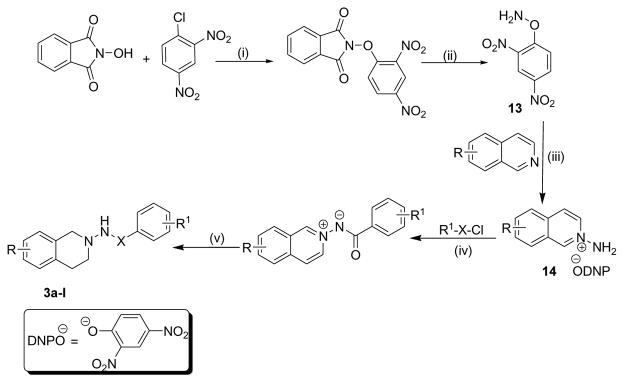
Reaction Conditions: (i) Et3N, RT, 2 hours, (ii) NH2.NH2. H2O, CH2Cl2, MeOH,0 °C, (iii) CH3CN, 50 °C,(iv) Et3N, THF, 25 °C, (v) NaBH4, EtOH, RT; X = CO, SO2 R= 5-OCH3, 5-OH, 5-NHCOCH3, 5-NH-CO-C6H4-C2H5, 5-OCH2-C6H5, 7-OCH3, 7-COOCH3, 5,8-di-Br, 6-COOH, 5-OSO2-C6H4-OCH3; R1 =4-C(CH3)3-C6H4, 4-C2H5-C6H4, 4-OCH3-C6H4